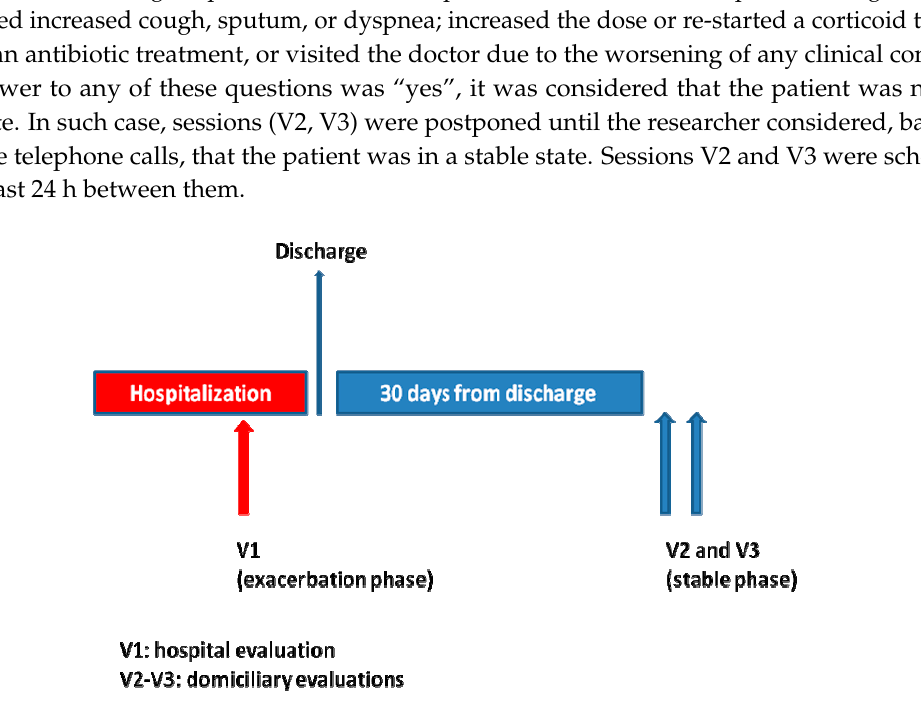
Figure 1. Timeline for evaluation sessions during the trial.